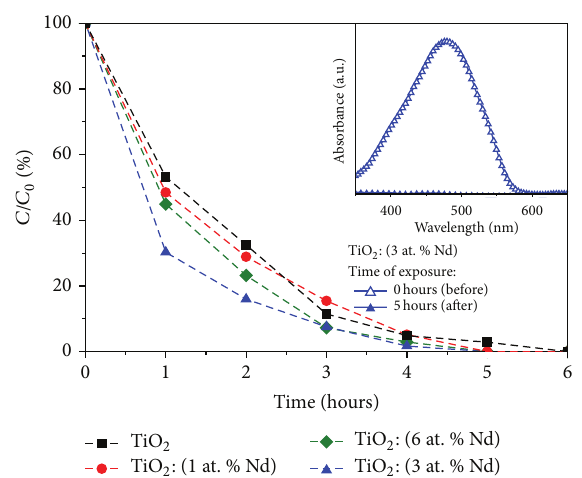
Figure 7: Photocatalytic activity of TiO 2 and TiO 2 :Nd (1, 3, and 6 at. % of neodymium) nanoparticles after exposure to the UV-Vis light. Designations: 𝐶 0 : initial concentration and 𝐶 : concentration of methyl orange after time 𝑡